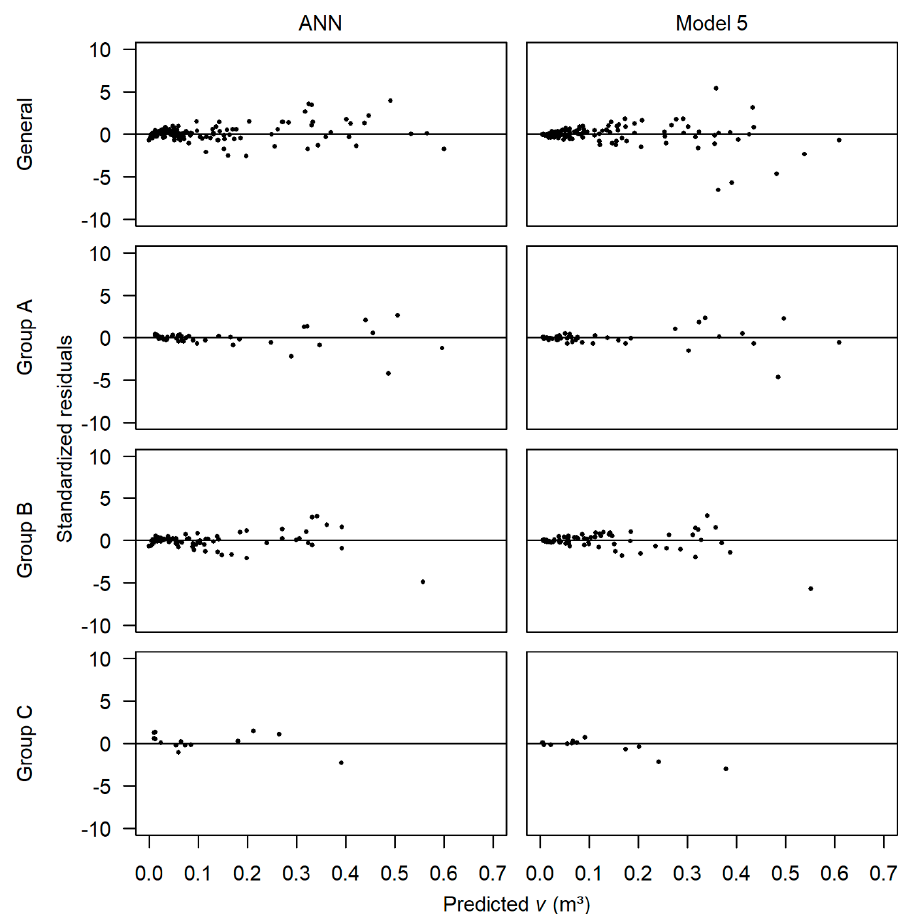
Figure 6. Dispersion of the standardized residuals as a function of the predicted commercial volume with bark up to 4 cm in diameter at the tree top ( v ), in the sample intensities of scenario (a).